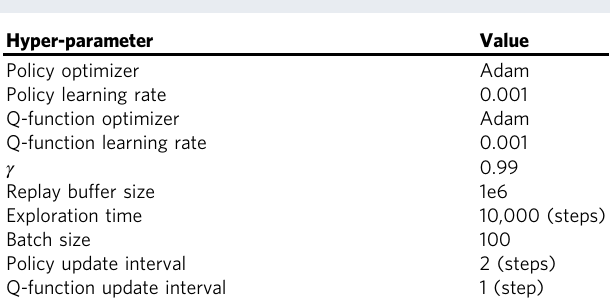
Table 4 TD3 agent